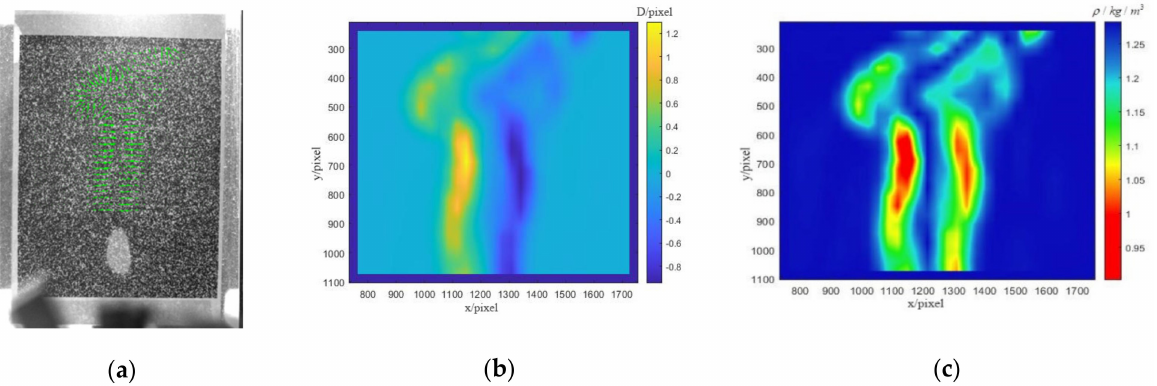
Figure 10. Displacement of flame. ( a ) Background displacement vector diagram, ( b ) horizontal displacement diagram, and ( c ) density field distribution